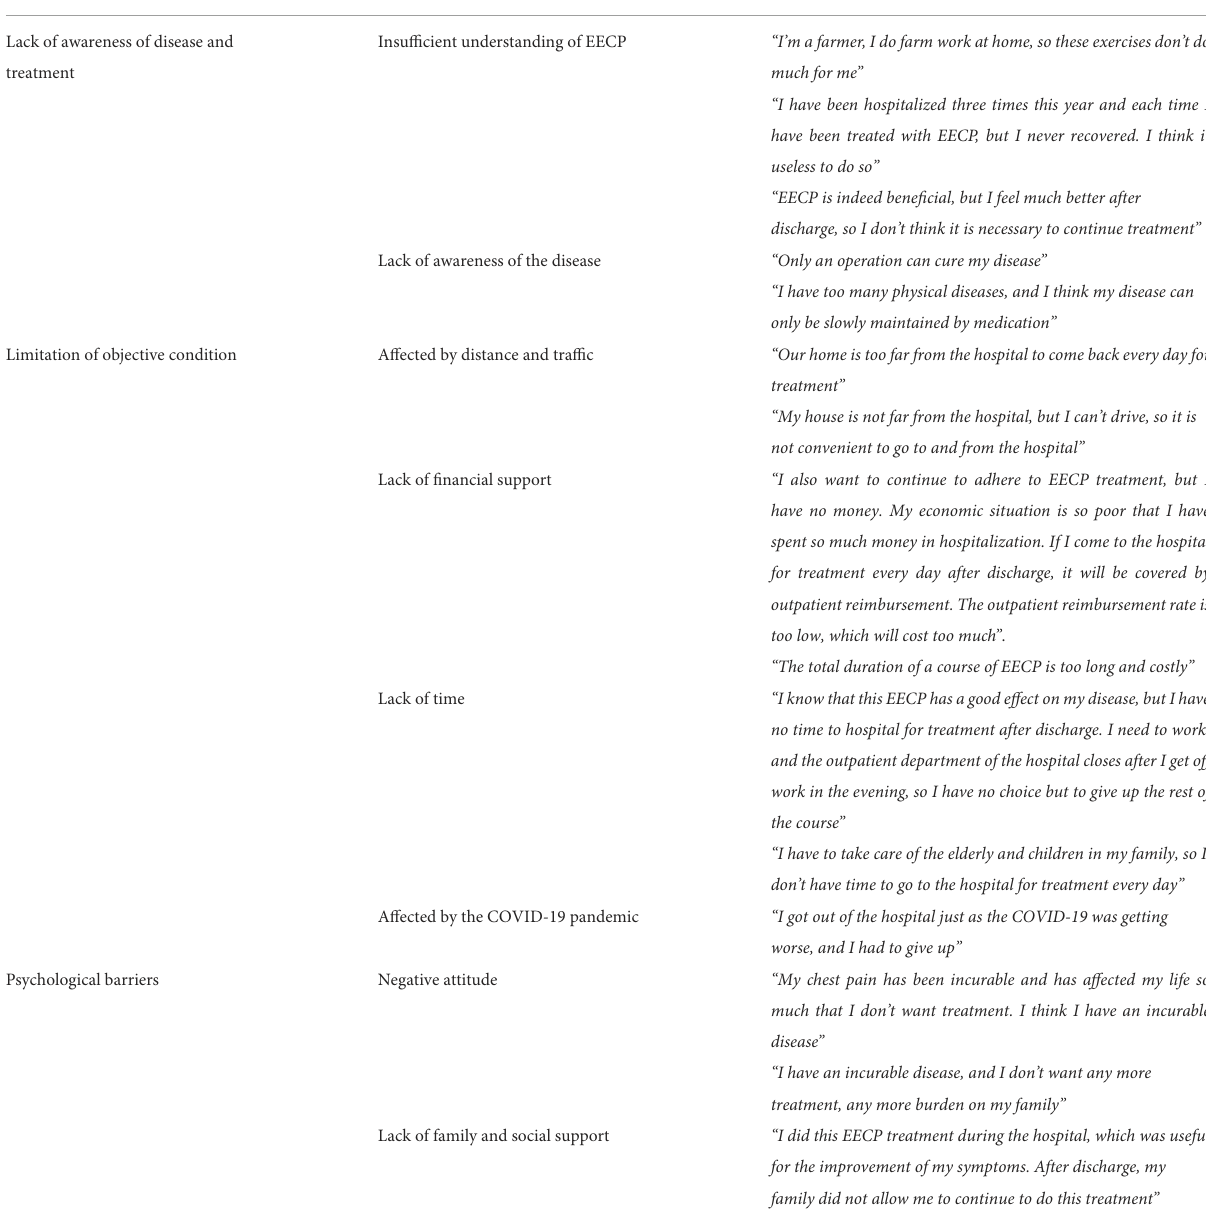
TABLE 4 Analysis of causes and representative quotes of non-adherence to EECP in CHD patients after